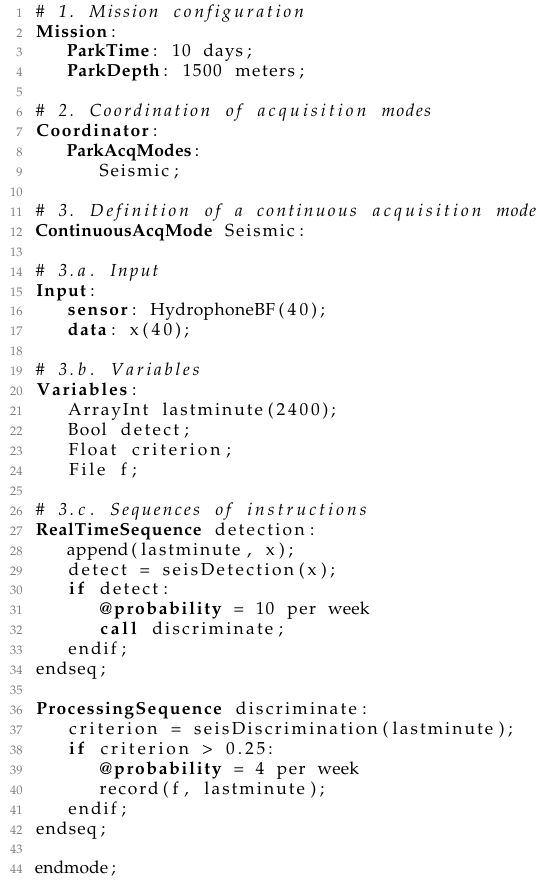
Figure 2. Application example. The functions ’seisDetection’ and ’seisDiscrimination’ have been left to keep the example short, they do not exist in the language, the real algorithm for seismic detection is presented in Section